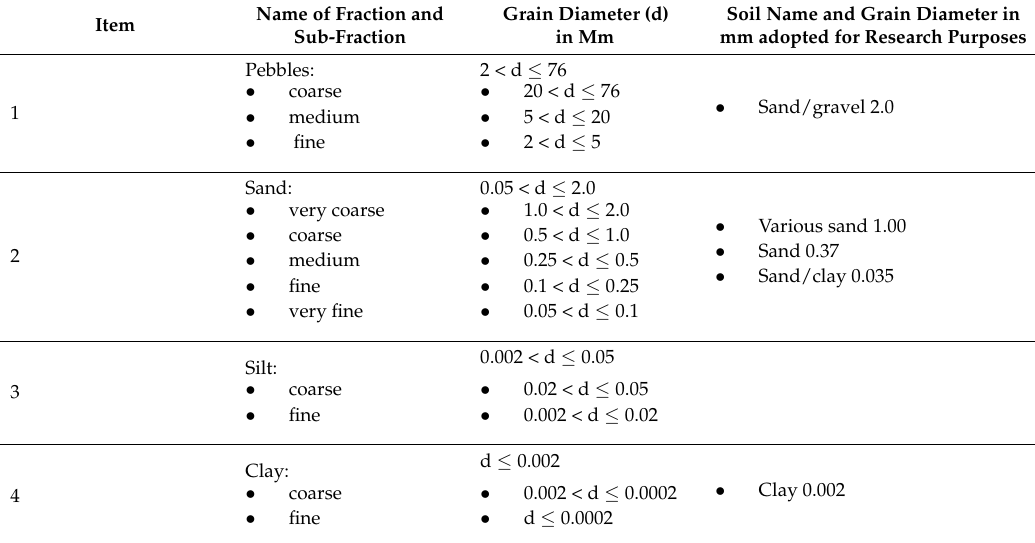
Table 2. The type of soil described in daily reports was converted into fractions, according to the following